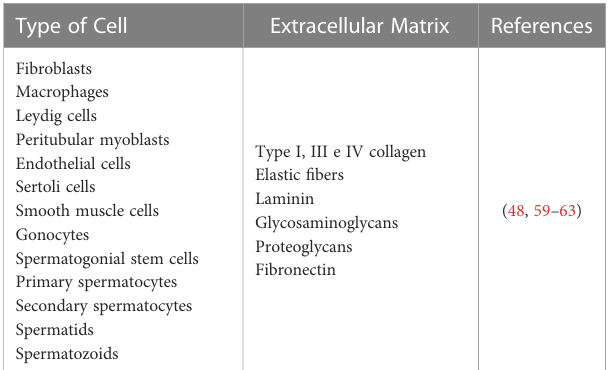
TABLE 1 Cellular and extracellular components of testicular and epididymal